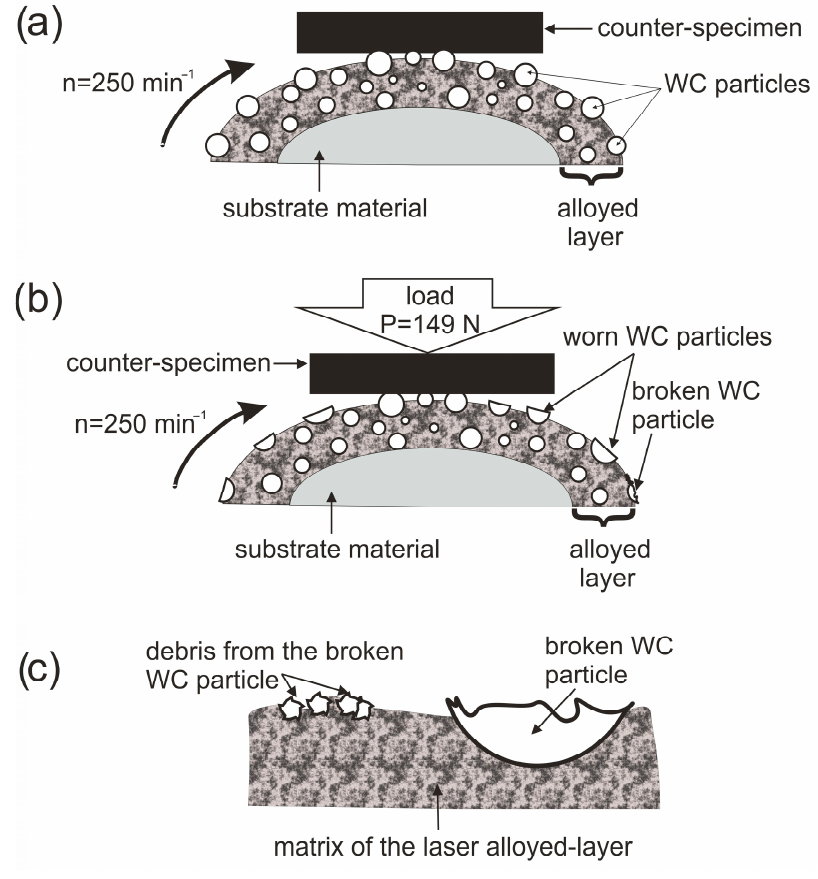
Figure 17. Schematic model of the wear behavior of the laser-alloyed layer produced on Inconel ® 600-alloy: ( a ) the contact between the specimen and counter-specimen, ( b ) first stage of wear, ( c ) details of the area with a broken WC particle and debris pressed into the matrix of the layer.